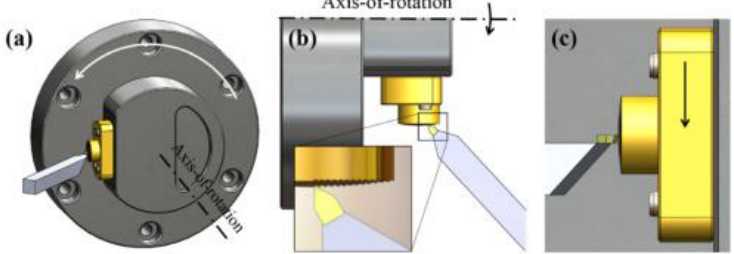
Figure 7. Schematic diagram of the multi-degree-of-freedom diamond tool holder [62]. ( a ) three- dimensional view, ( b ) top view, ( c ) front view.